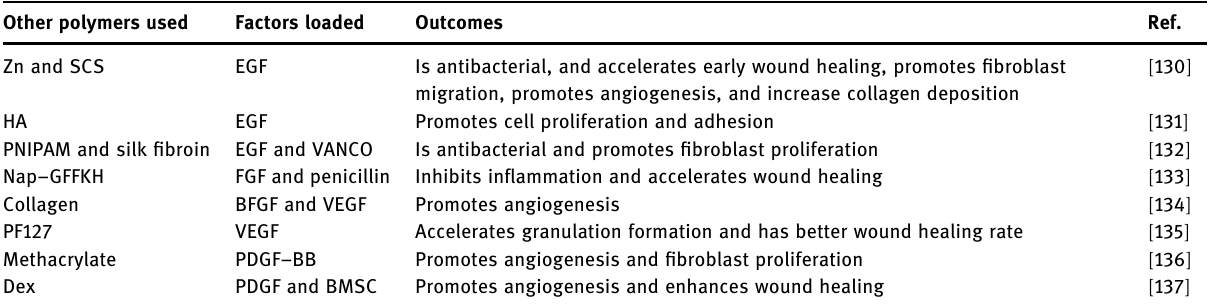
Table 3: Summary of alginate hydrogel loaded with growth factors in wound healing Other polymers used